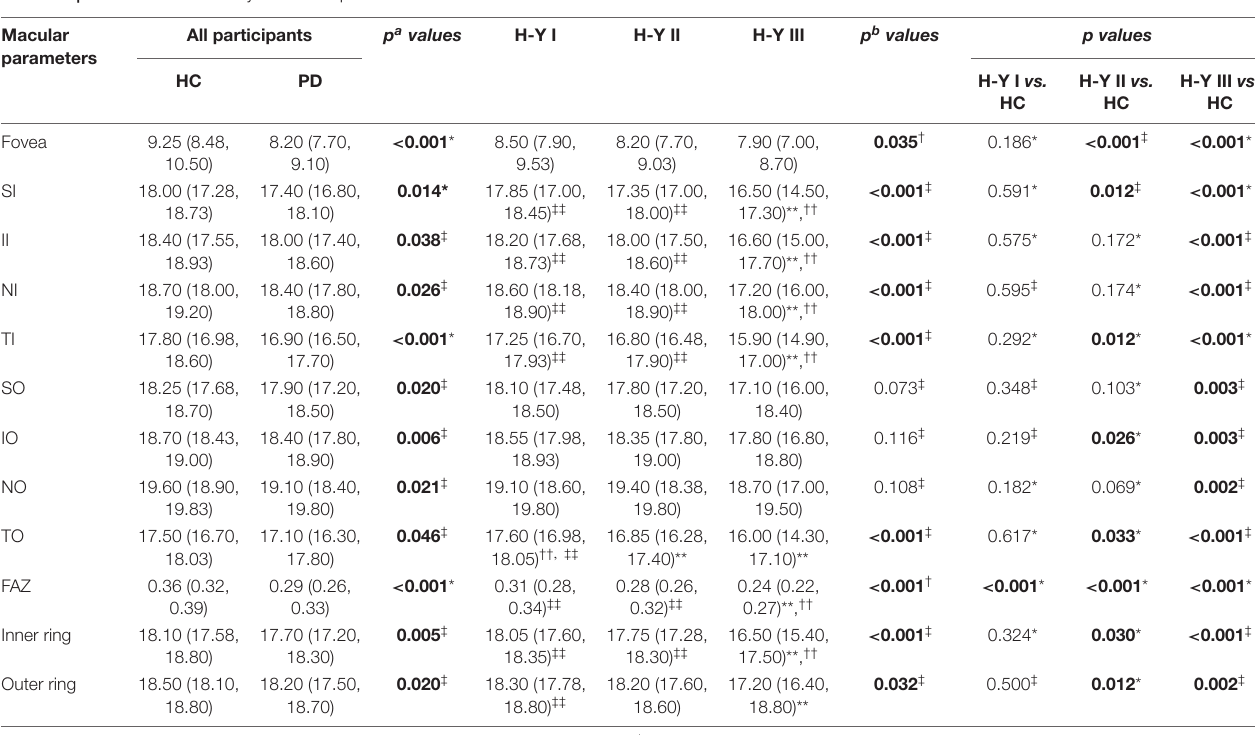
FIGURE 2 | The comparison of vessel density parameters among different PD subgroups (A) in the macula area; (B) in the peripapillary area. Compared with HC groups, macular vessel density (m-VD) in the PD group was significantly declined in all quadrants. Additionally, peripapillary vessel density (p-VD) was found significantly decreased in the fovea, nasal inner (NI), temporal outer (TO), and outer ring regions in the PD group, * p < 0.05. TABLE 2 | Macular vessel density in HC and patients with